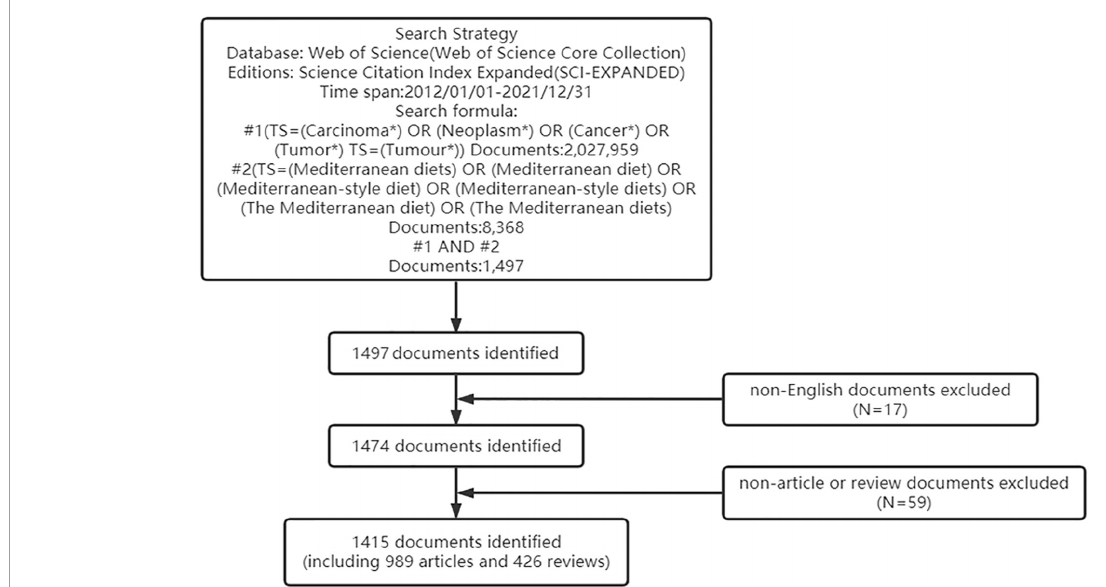
FIGURE1 Search strategy and data filtering process.